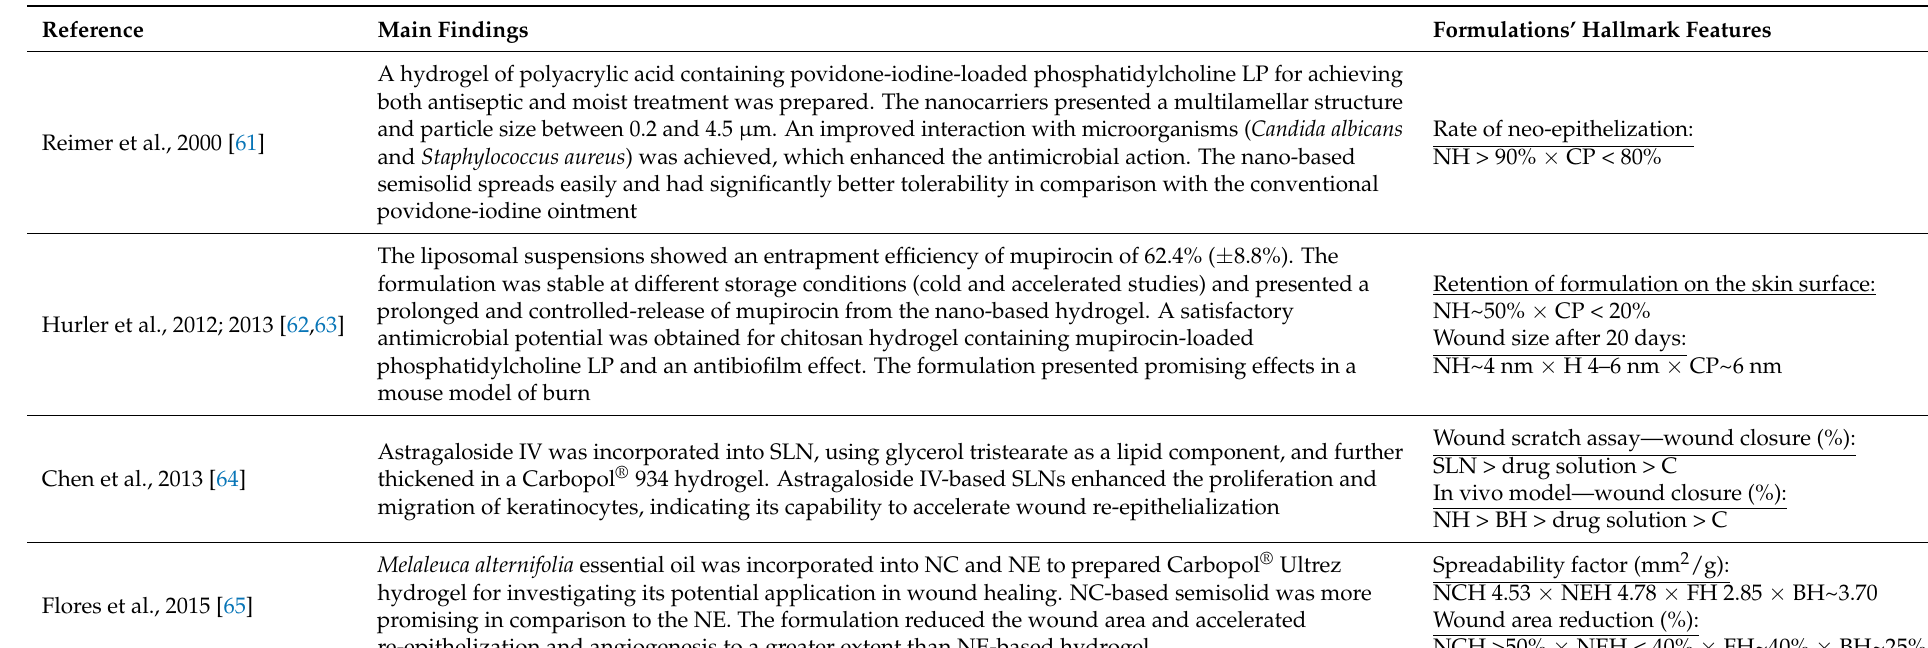
Table 2. Main findings of the studies and advantages conferred by